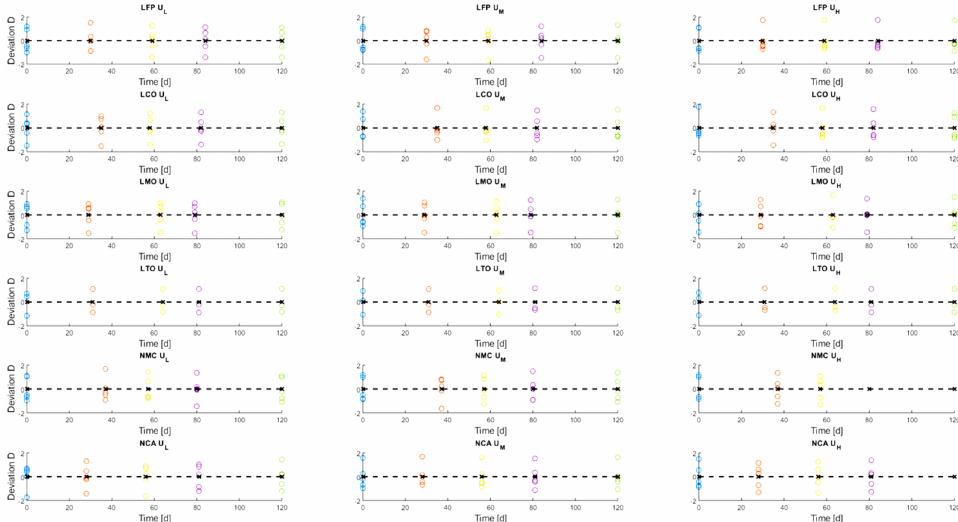
Figure 9. Calculated deviation relative D of the checked cells over the course of 120 days stored at 60 ◦ C. Each row shows a different electrode material and each column displays the different storage voltages (U L -voltage low, U M -voltage mid, U H -voltage